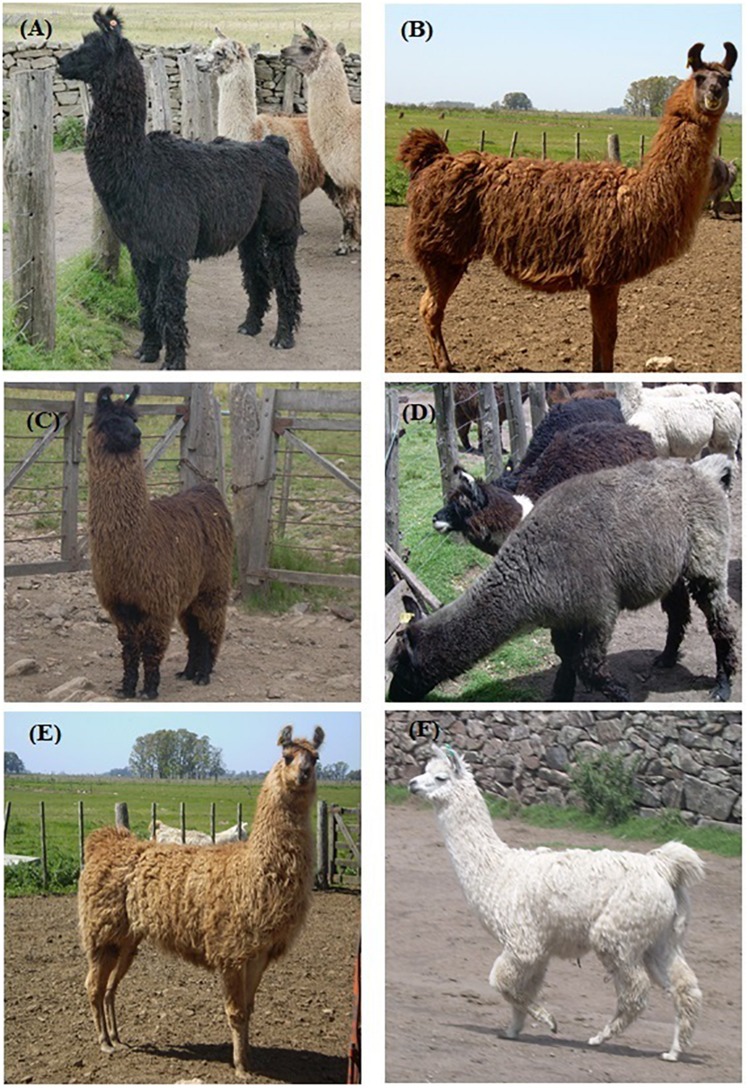
Photographs of llamas illustrating color phenotypes included in this study. (A) Black, (B) Red, (C) Black Face, (D) Gray, (E) Fawn, and (F) White.